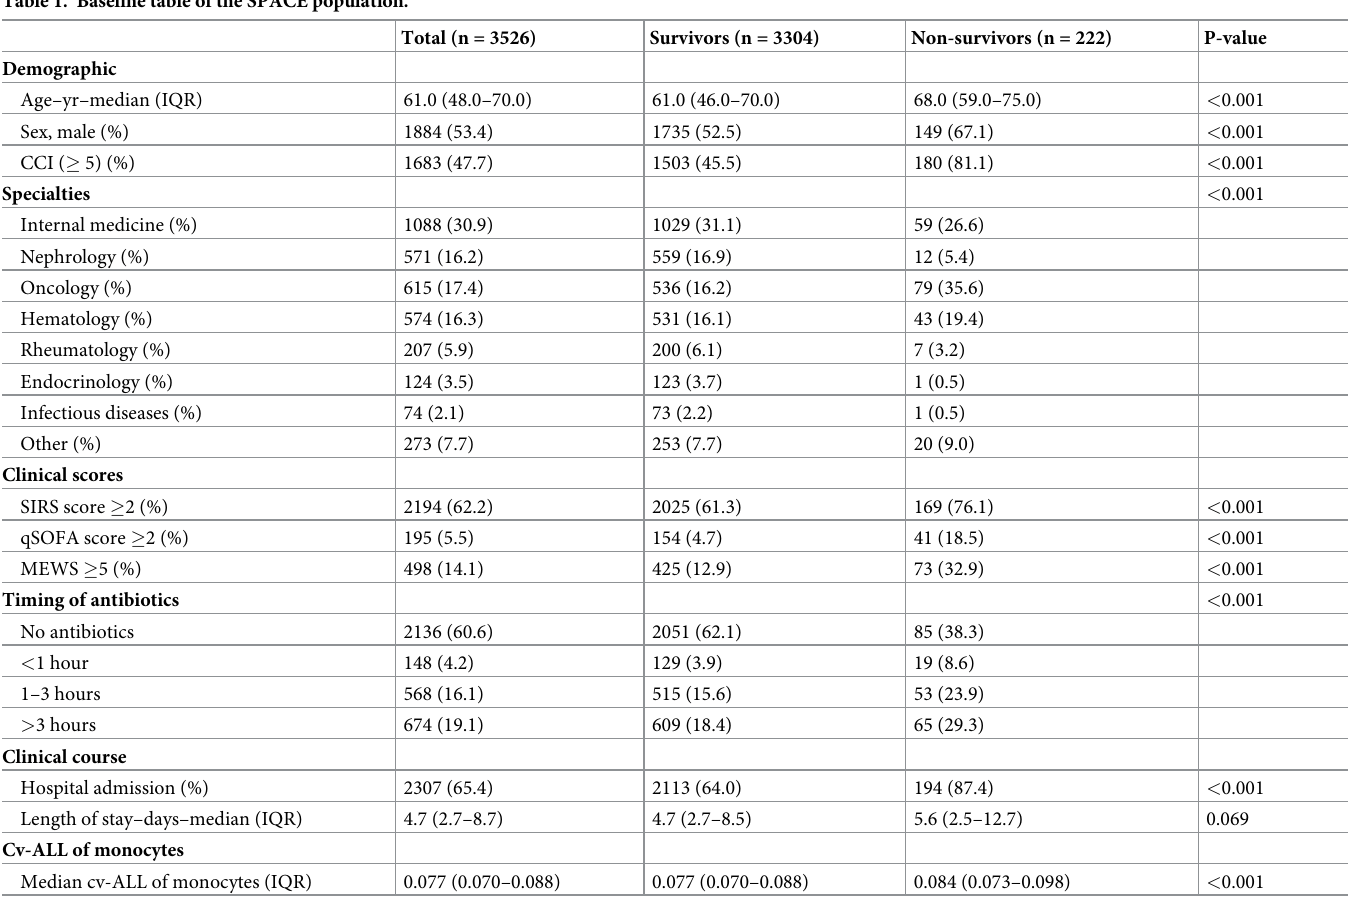
Table 1. Baseline table of the SPACE population.